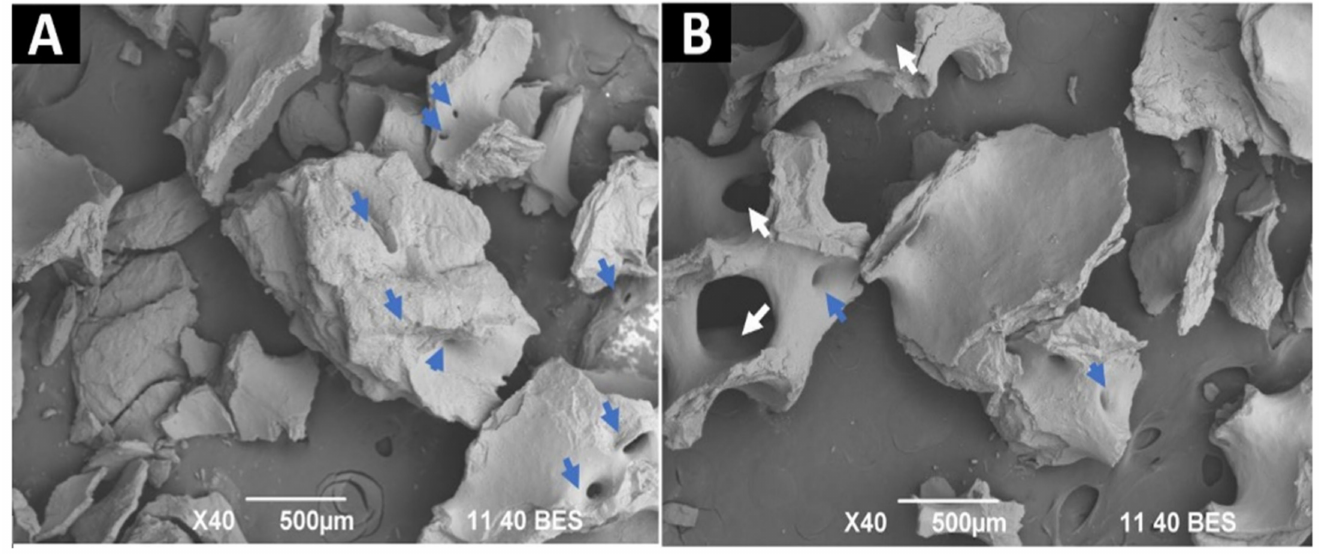
Figure 6. F1 (InterOss) SEM analysis. ( A , B ) 40 × . Blue arrows: pores. White arrows: trabeculae with medullary